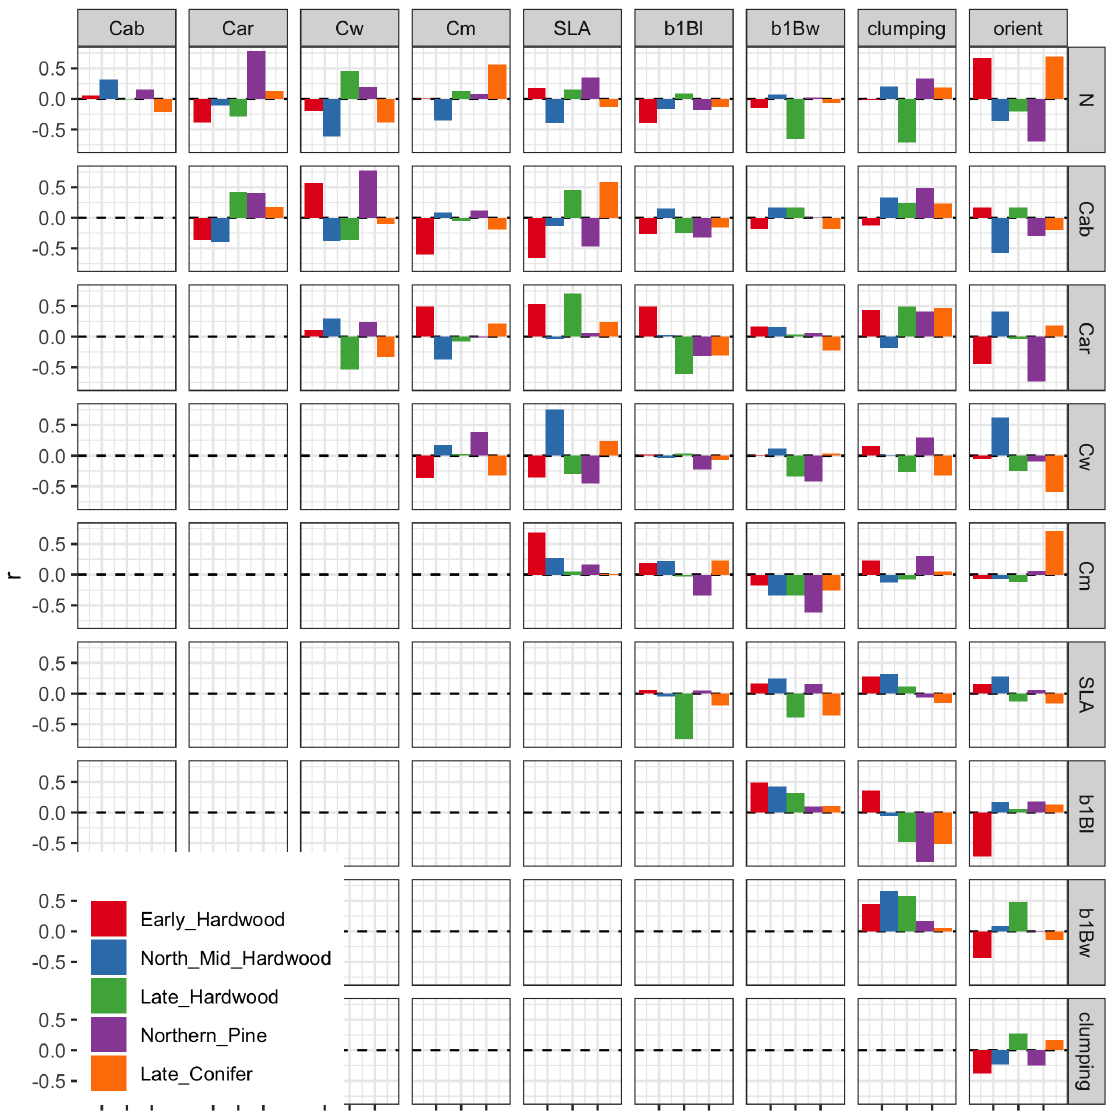
Figure A17. Posterior correlation matrix for PFT-specific parameters. Note that only correlations among parameters within the same PFT are shown – the full 106 × 106 dimensional correlation matrix is far too large to display in this